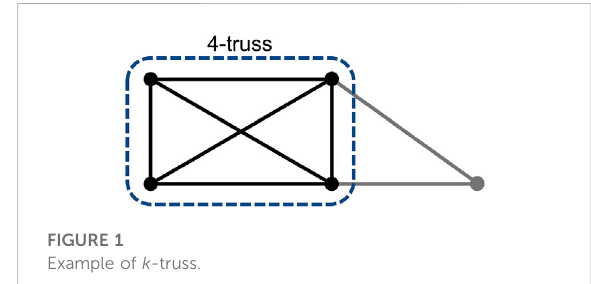
FIGURE 1 Example of k